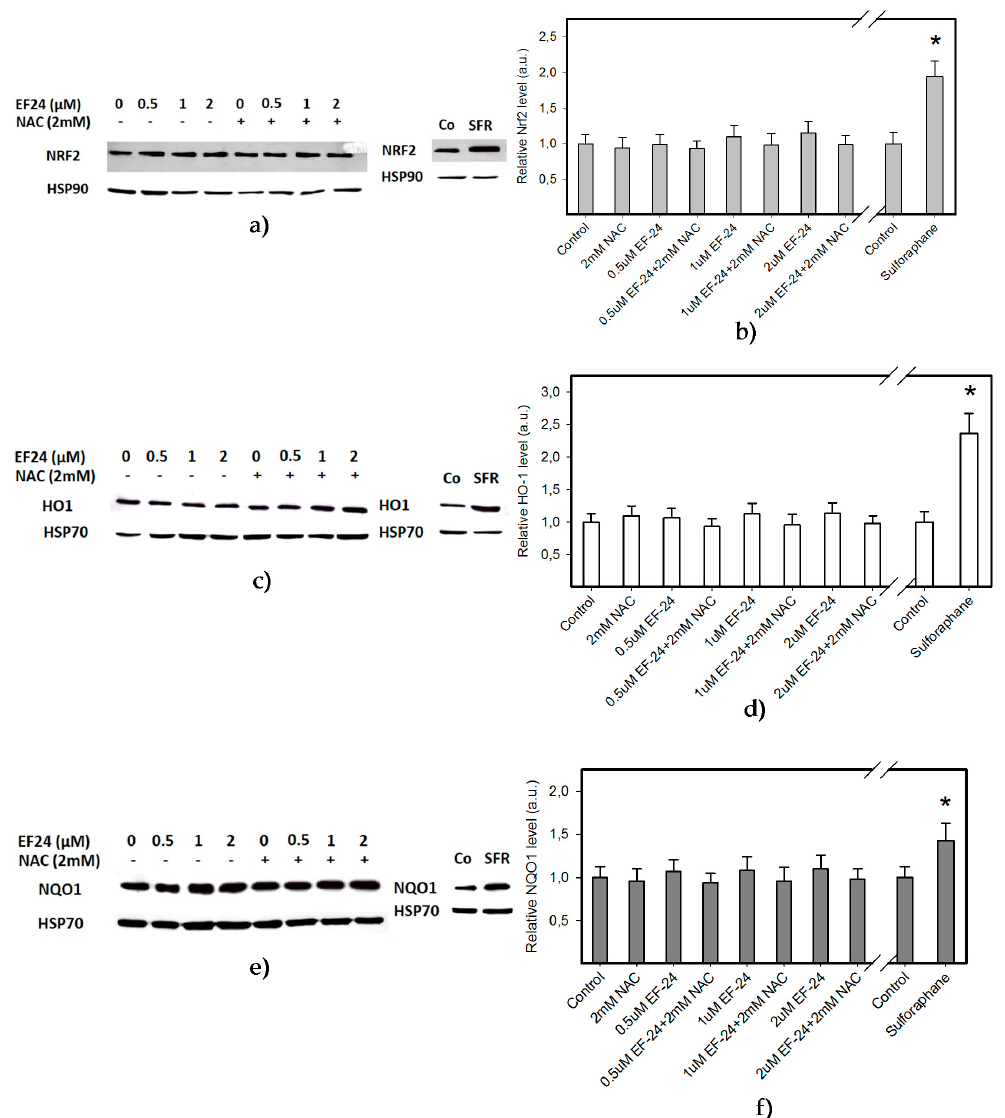
Figure 4. Effect of EF-24 on the activation of Nrf2 regulated signaling pathway. Cells were treated with EF-24 or with EF-24 + 2 mM NAC, as indicated. Incubation proceeded for 6 h prior to Western blot analysis. Treatment of cells with sulforaphane was used as a positive control [21]. ( a ) Effect of EF-24 on the activation of Nrf2. A representative example. ( b ) A quantitative analysis of the effect of EF-24 on the activation of Nrf2; * denotes significant change in the Nrf2 level ( p < 0.05) between untreated K562 cells and cells treated with sulforaphane. ( c ) Effect of EF-24 on the activation of heme oxygenase-1 (HO-1). A representative example. ( d ) A quantitative analysis of the effect of EF-24 on the activation of HO-1; * denotes significant change in the HO-1 level ( p < 0.05) between untreated K562 cells and cells treated with sulforaphane. ( e ) Effect of EF-24 on the activation of NAD(P)H:quinon oxidoreductase 1 (NQO1). A representative example. ( f ) A quantitative analysis of the effect of EF-24 on the activation of NQO1; * denotes significant change in NQO1 levels ( p < 0.05) between untreated K562 cells and cells treated with sulforaphane.